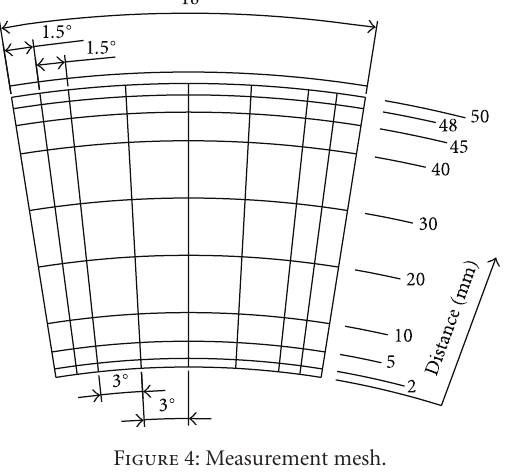
Table 1: Specifications of the annular